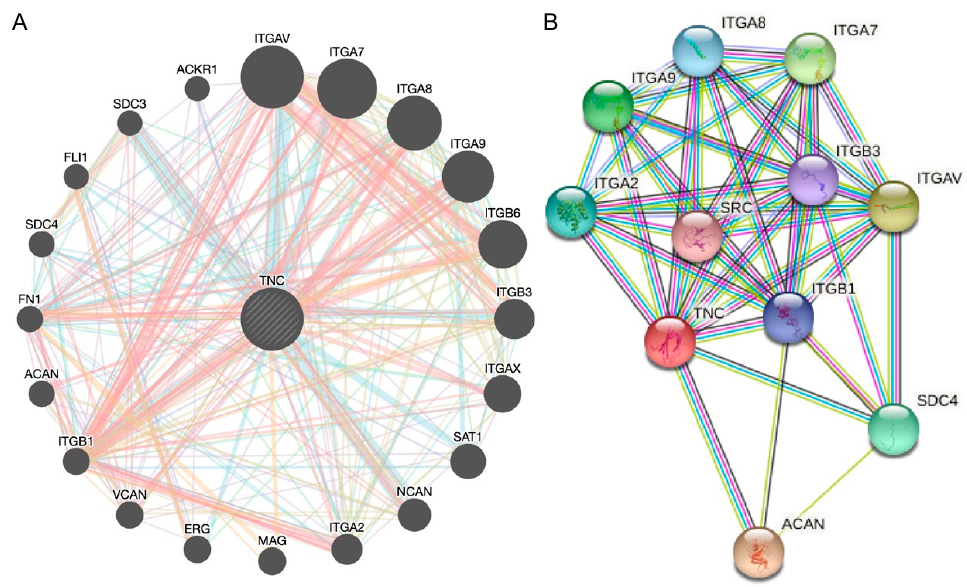
Figure 7. Analysis of neighbouring gene networks in lung cancer. ( A ) The gene–gene interaction network of TNC constructed using GeneMania. ( B ) The protein–protein interaction network of TNC generated using STRING.